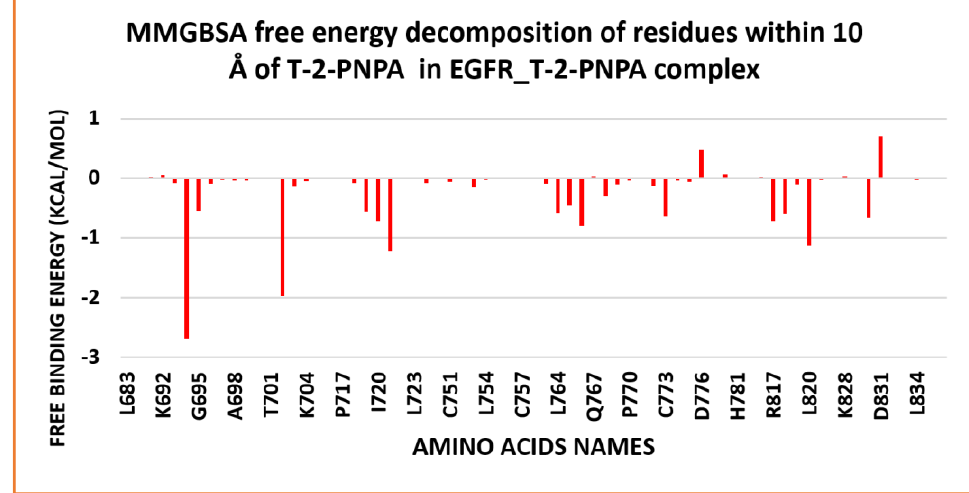
Figure 9 . Binding free energy decomposition of the EGFR – T-2-PNPA complex.